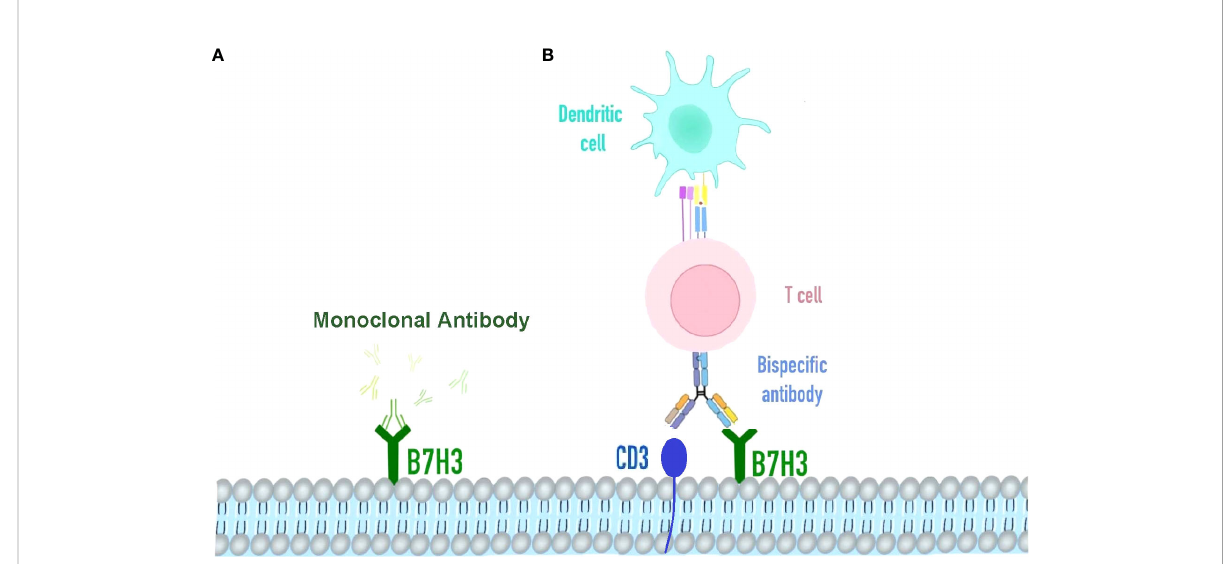
FIGURE 3 Immunotherapy strategy targeting B7H3. (A) Omburtamab is a radionuclide iodine-131-labeled monoclonal antibody targeting B7H3 cells in various solid tumors, including retinoblastoma. It binds to the FG cyclically dependent conformation, a key region of the biological function of the B7-H3 molecule. (B) Bispeci fi c antibody of B7H3 and CD3, redirecting T cells and accessory immune cells.